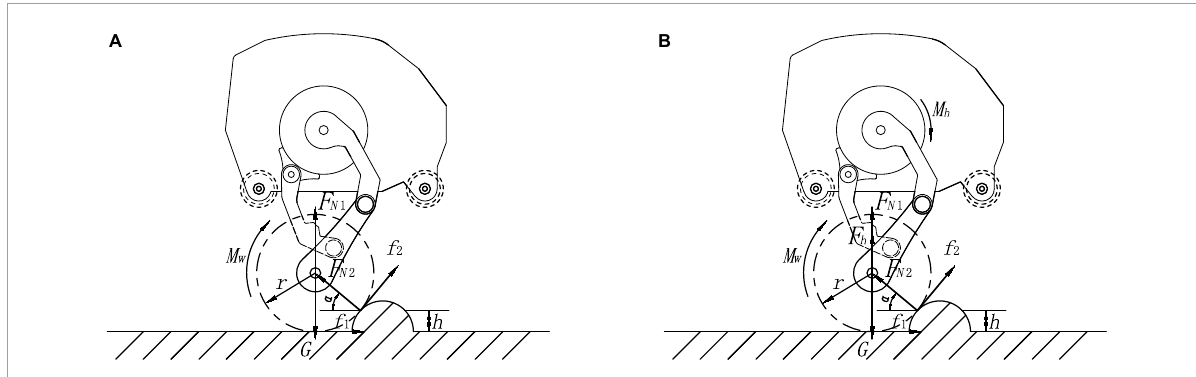
FIGURE6 Wheel over obstacles in wheel-leg mode: (A) Cross obstacle on two legs; (B) Cross obstacle on one leg.